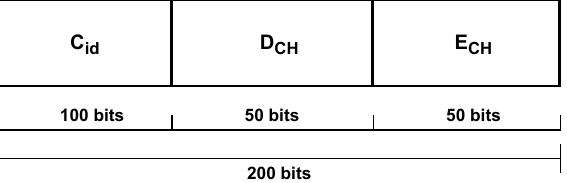
Figure 5. Advertisement message packet format.